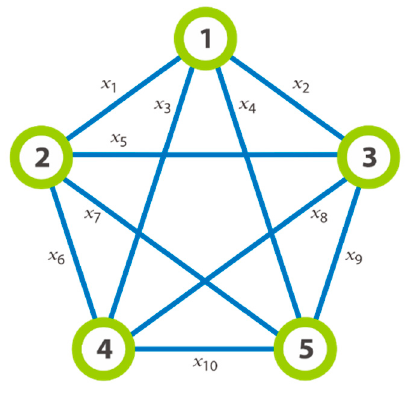
Figure 1. Instance of a graph G.